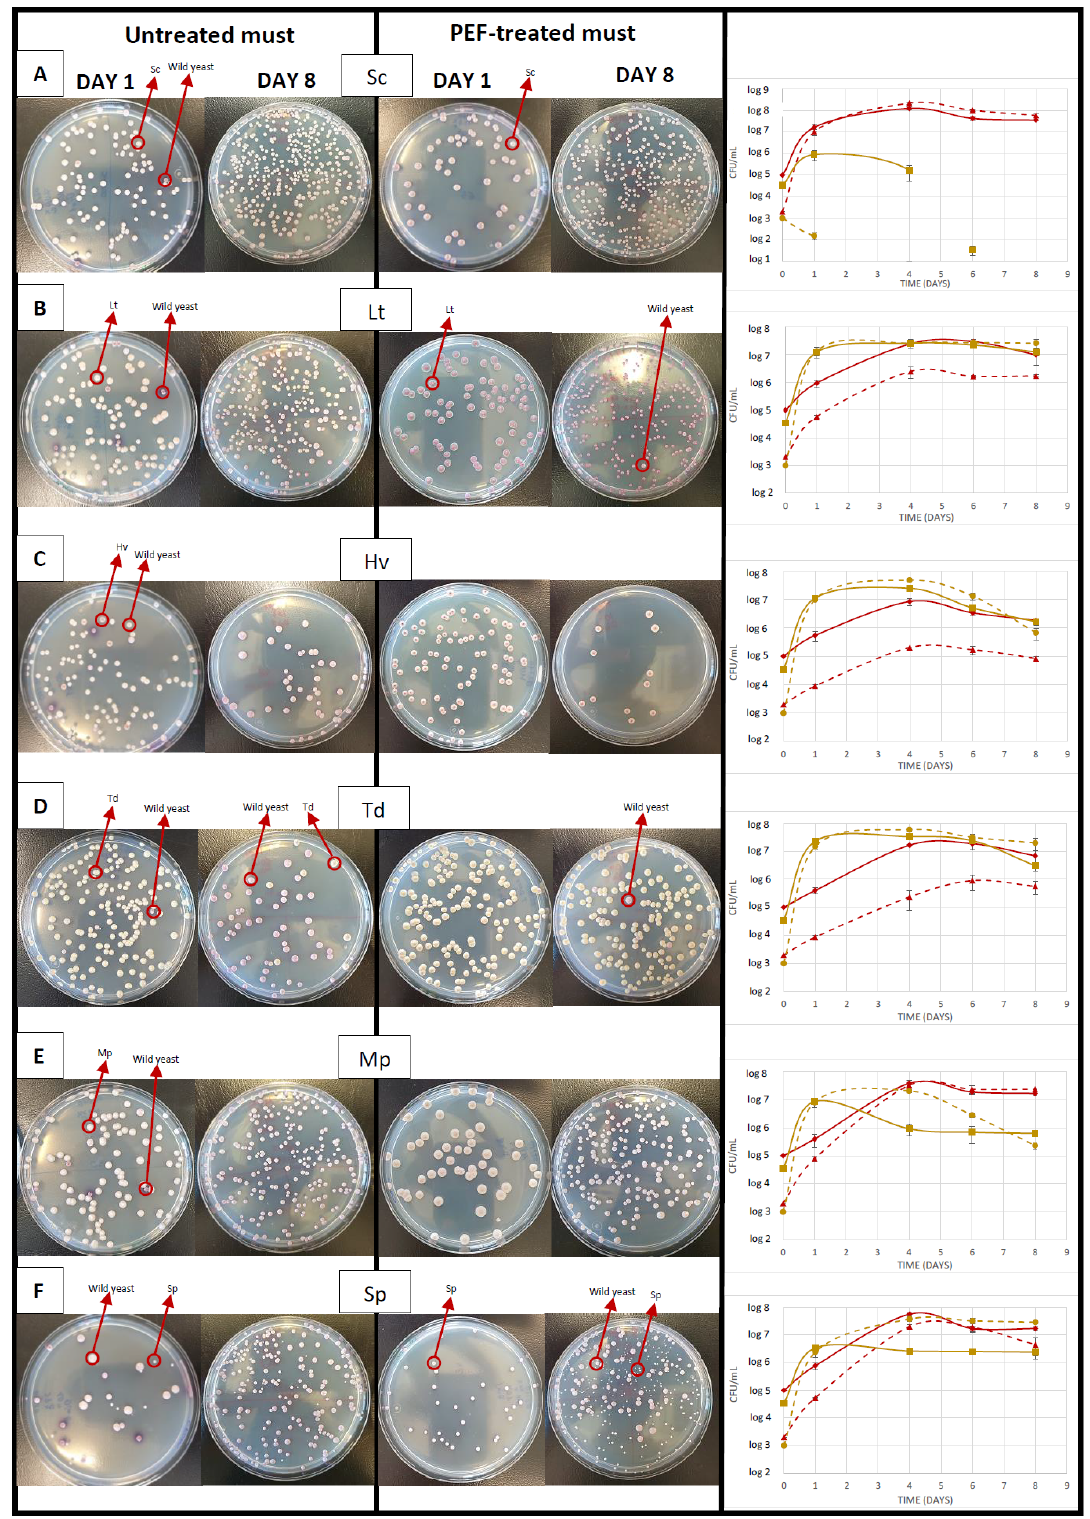
Figure 3. Days 1 and 8 plates of the different fermentations with and without PEF and CFU/mL counts throughout fermentation of untreated must with Saccharomyces (solid red line) and non- Saccharomyces yeasts (solid yellow line), in PEF-treated must with Saccharomyces yeasts (dashed red line) and non- Saccharomyces yeasts (dashed yellow line). Musts were inoculated with ( A ) S. cerevisiae , ( B ) L. thermotolerans , ( C ) H. vineae , ( D ) T. delbrueckii , ( E ) M. pulcherrima , and ( F ) S. pombe . Values are means with standard deviations (error bars) from three independent triplicates.